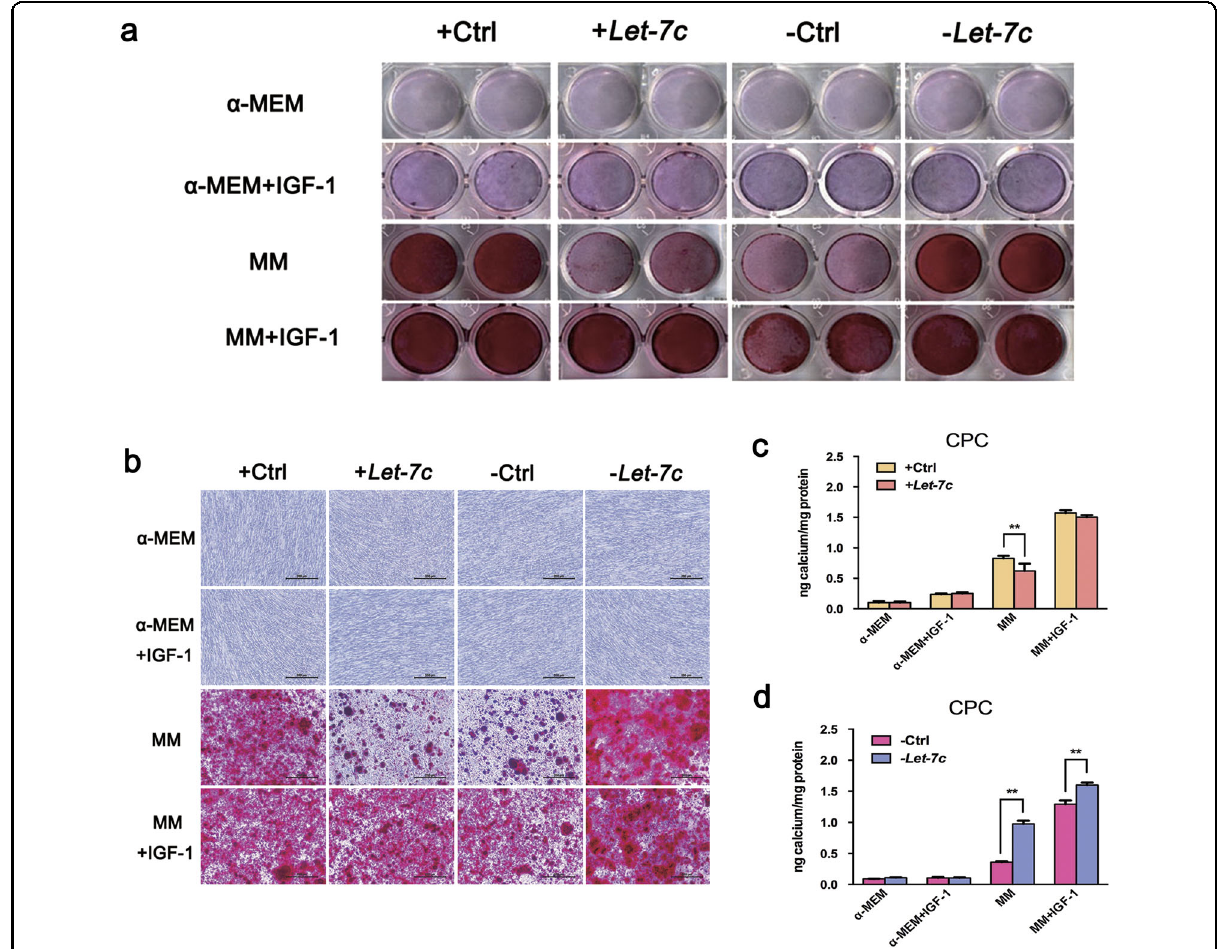
Fig. 5 Effects of let-7c on the mineralization ability of IGF-1-treated DPMSCs analyzed by Alizarin red staining. a Representative alizarin red staining images from + Let-7c , + Ctrl, − Let-7c , and – Ctrl DPMSCs cultured in α -MEM, α -MEM + IGF-1, mineralization media (MM), or MM + IGF-1 media. b Calcium nodules in different groups were visualized under an inverted microscope. c Calcium quanti fi cation demonstrated that the calcium content was signi fi cantly lower in + Let-7c DPMSCs compared to + Ctrl DPMSCs in the MM group. d The calcium content was signi fi cantly higher in − Let-7c DPMSCs compared to − Ctrl DPMSCs in both the MM and MM + IGF-1 groups. Values are presented as the mean ± SD, n = 3. ** P < 0.01.